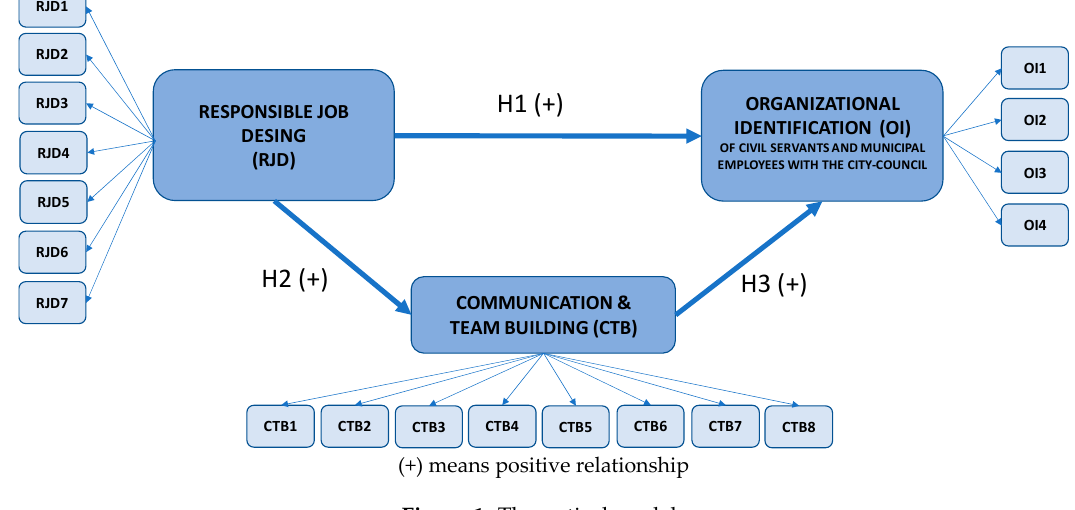
Figure 1. Theoretical model.